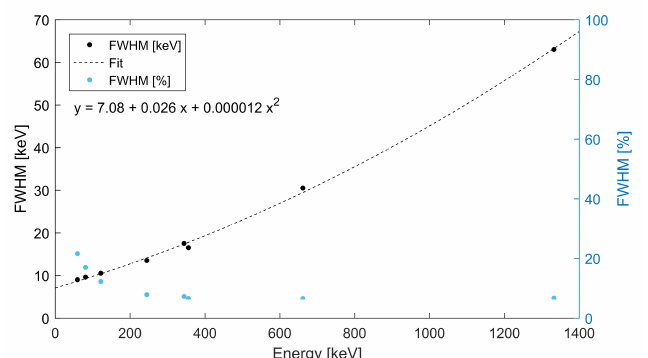
Figure 8. Energy resolution for spectrometry of X rays and gamma rays with a Timepix detector with a 2000 µ m thick CdTe sensor. Absolute values of the full width at half maximum (in black—see left vertical axis) are fitted by polynom fuction (given in inset). The FWHM is included in relative values (in blue)—see right vertical